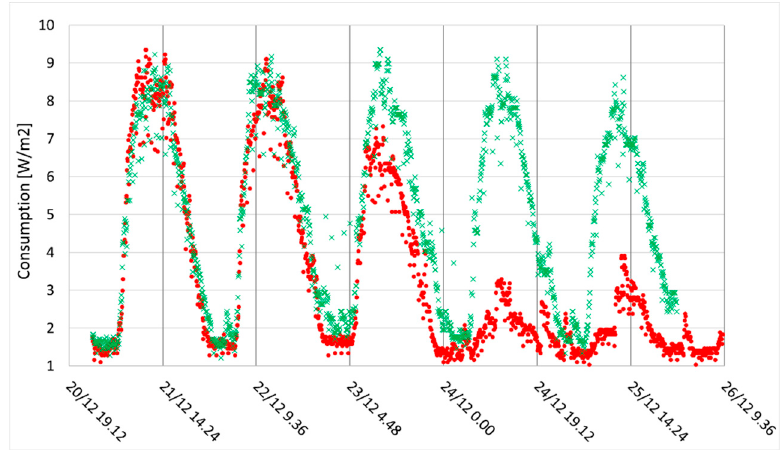
Figure 18. Measurements for Christmas 2015, Mon 21st to Fri 25th (dots) compared to a June working week (crosses).